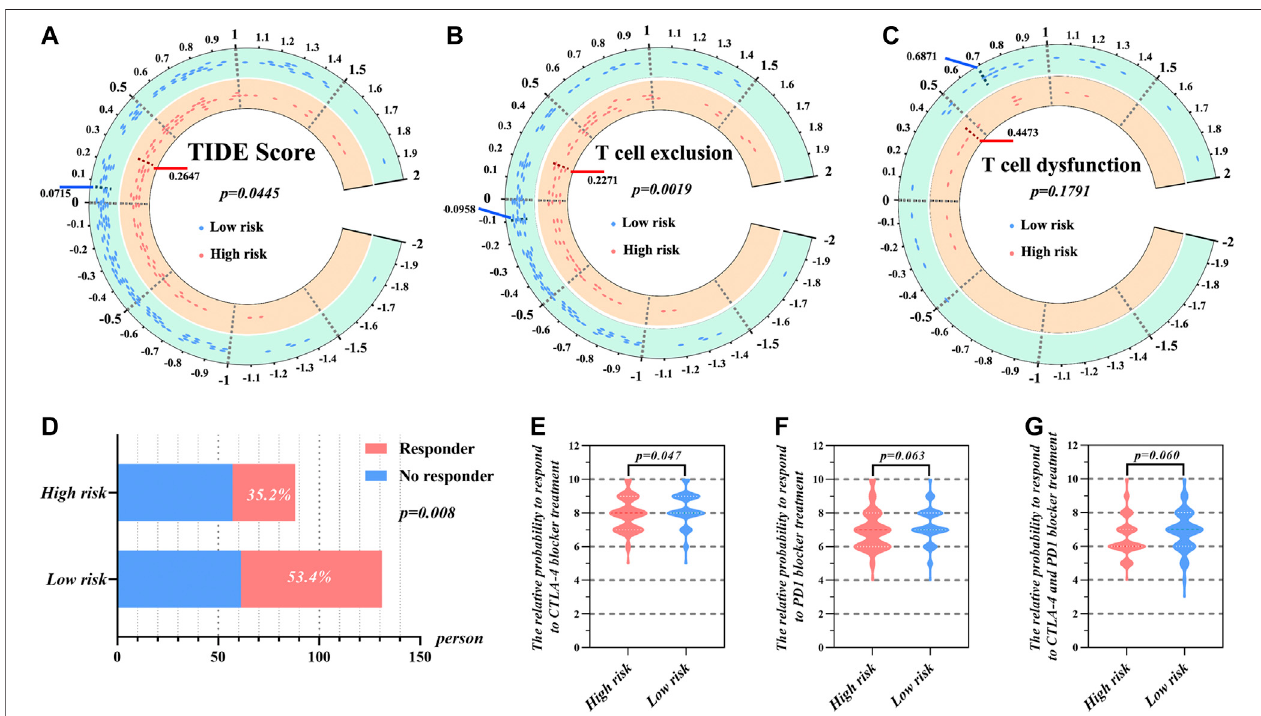
FIGURE 6 | The prediction of response to immunotherapy of HCC patients in high- and low-risk group according to risk score. (A) The distribution of TIDE score, (B) Tcellexclusionscore,and (C) Tcelldysfunctionscoreinhigh-and low-riskgroups. (D) Thecomparison ofbene fi ciaries fromimmunotherapybetweenthehigh-and low-risk group. The relative probabilities of respond to CTLA-4 blocker treatment (E) , PD-1 blocker treatment (F) and the combination of CTLA-4 and PD-1 blocker treatment (G) in the low- and high-risk